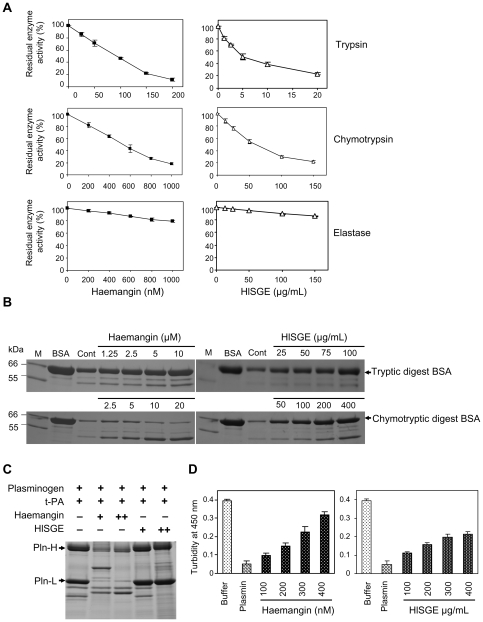
Inhibition of serine proteinases.(A) Inhibition of hydrolytic activity of trypsin, chymotrypsin, and elastase on synthetic substrates. Enzyme inhibition assays were performed using fluorogenic substrates by measuring the residual hydrolytic activity after pre-incubation with increasing concentrations of Haemangin or HlSGE. The final concentrations of enzyme/substrate used were as follows: trypsin (5.6 nM)/Substrate (10 µM), chymotrypsin (5 µM)/Substrate (10 µM), and elastase (51 nM)/Substrate (10 µM). Each enzyme was pre-incubated with an increasing concentration of Haemangin at 37°C for 30 min. After pre-incubation of enzyme and inhibitor, appropriate fluorogenic substrate was added. The total volume of reaction mixture was 200 µl in individual wells in 96-well flat bottomed plates. The residual enzyme activity was measured by reading the fluorescence over time at excitation and emission wavelengths of 360 and 460 nm, respectively. PMSF was used as a positive control. Percent inhibition by Haemangin is assessed by the following formula: % inhibition = (1–inhibited rate/uninhibited rate)×100. Error bars indicate the standard error of the mean (n = 3). (B) Inhibition of BSA proteolysis by trypsin and chymotrypsin. Proteolysis inhibition assays were done by pre-incubating the enzymes with increasing concentration of Haemangin or HlSGE in 20 mM Tris-HCl (pH 8.0) in a total reaction mixture of 40 µl for 1 h at 37°C. Then, BSA (500 µg/ml) was added to the inhibited and uninhibited enzymes (250 µg/ml) (control) and was further incubated overnight at 37°C. The following morning, tryptic digests were electrophoresed in 12.5% SDS-PAGE under reducing condition. Molecular weight markers in kDa (lane M) are shown on the left. (C) Effects of Haemangin on plasmin degradation during fibrinolysis. Fibrinogen (8 µM) and thrombin (0.83 NIH unit/ml) were incubated in a buffer containing 50 mM Tris-HCl (pH 7.5), 100 mM NaCl, and 5 mM CaCl2 at 25°C for 30 min. After the fibrin was completely polymerized, lysis of fibrin polymer was initiated by the addition of 20 µM plasminogen and 15 nM t-PA. Reactions were started in the absence or presence of 200 nM (+) and 400 nM (++) Haemangin, and 150 µg/ml (+) and 300 µg/ml (++) HlSGE separately. The reaction mixtures were incubated overnight at 25°C and were subjected to 8% SDS-PAGE under reducing condition. (D) Inhibition of plasmin-dependent fibrin polymer lysis. Fibrinogen (8 µM) and thrombin (0.83 NIH unit/ml) were incubated in a buffer mentioned in (C). After fibrin polymerization was completed, a 100 µl buffer alone or buffer containing plasmin (1.5 µM) without or with an increasing concentration of Haemangin or HlSGE was added to initiate fibrinolysis. Error bars indicate the standard error of the mean (n = 3).